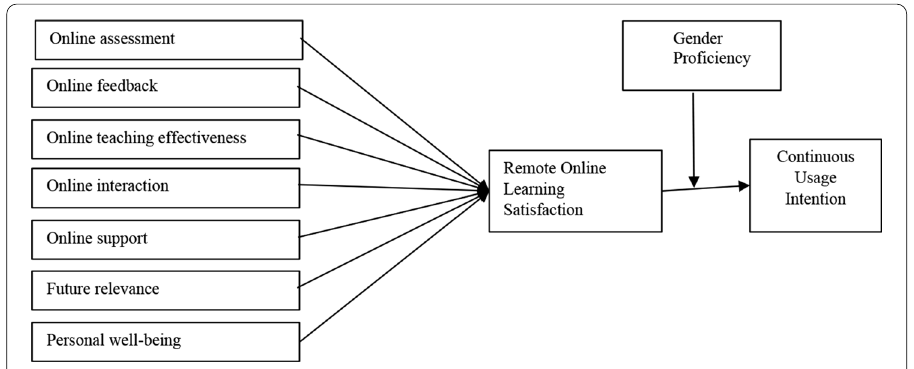
Fig. 1 Proposed conceptual